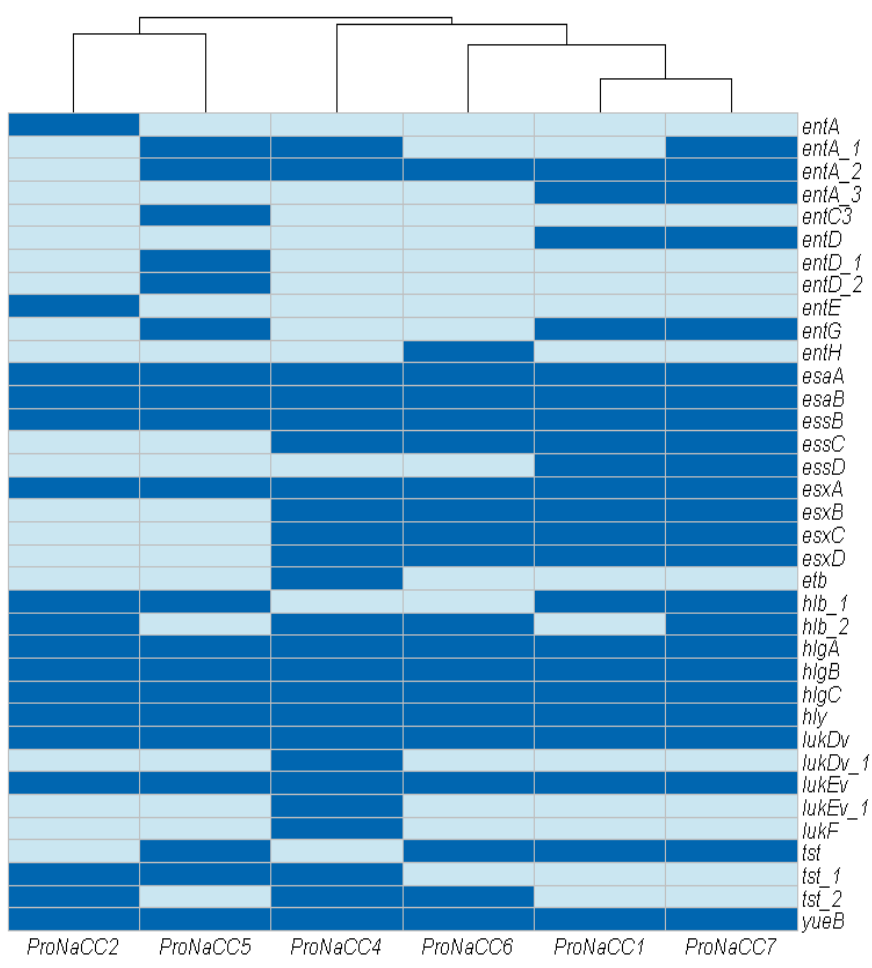
Figure 6. Heat map showing the genes coding for toxins and secretion machinery factors among the six enterotoxigenic S. aureus strains (dark blue: sequence detected; light blue: sequence not